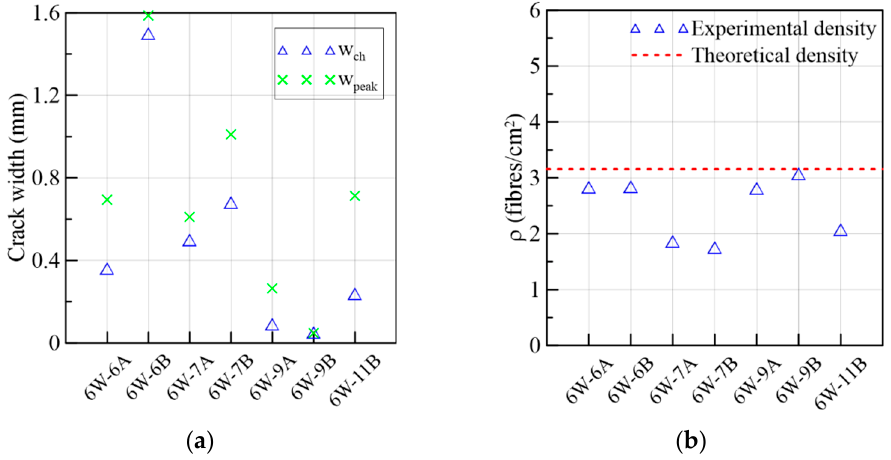
Figure 10. Mechanical results of 6W specimens: ( a ) crack widths at the change in behavior and at the peak load and ( b ) fiber densities.